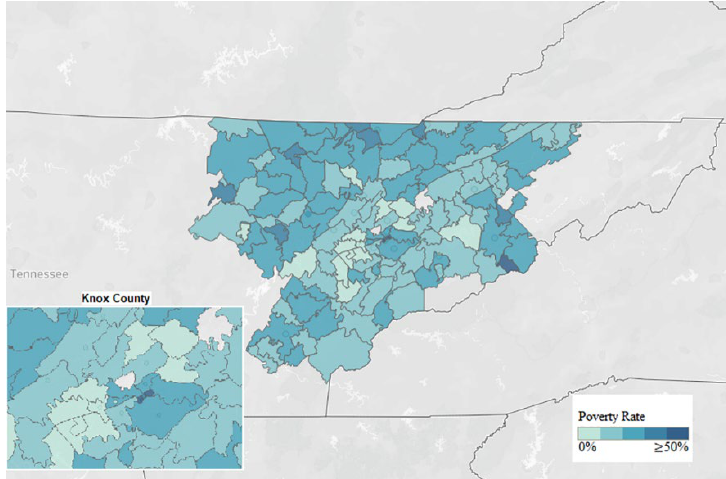
Figure 3 Poverty rates by zip code in hospital’s service